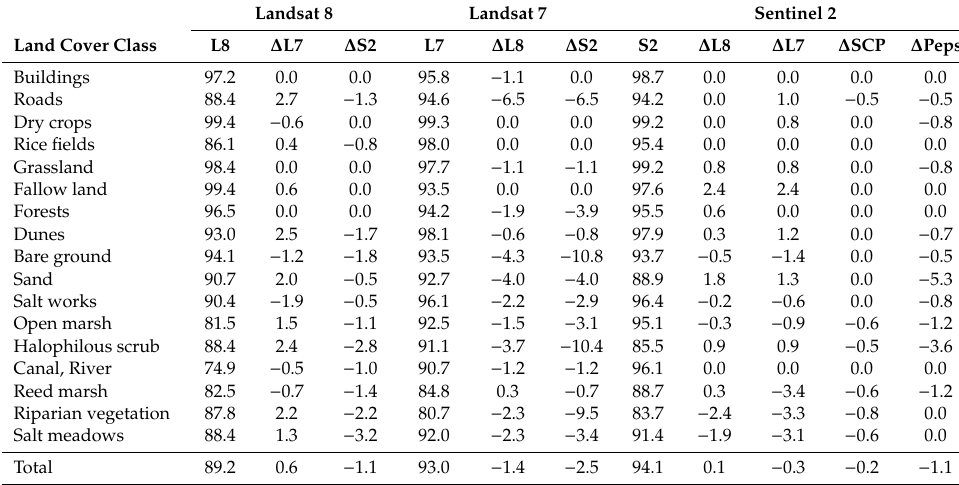
Table 4. Di ff erence in % overall accuracy according to the original satellite used for classification and the radiometric correction used for Sentinel 2 when applying the WIW logical rule. Landsat